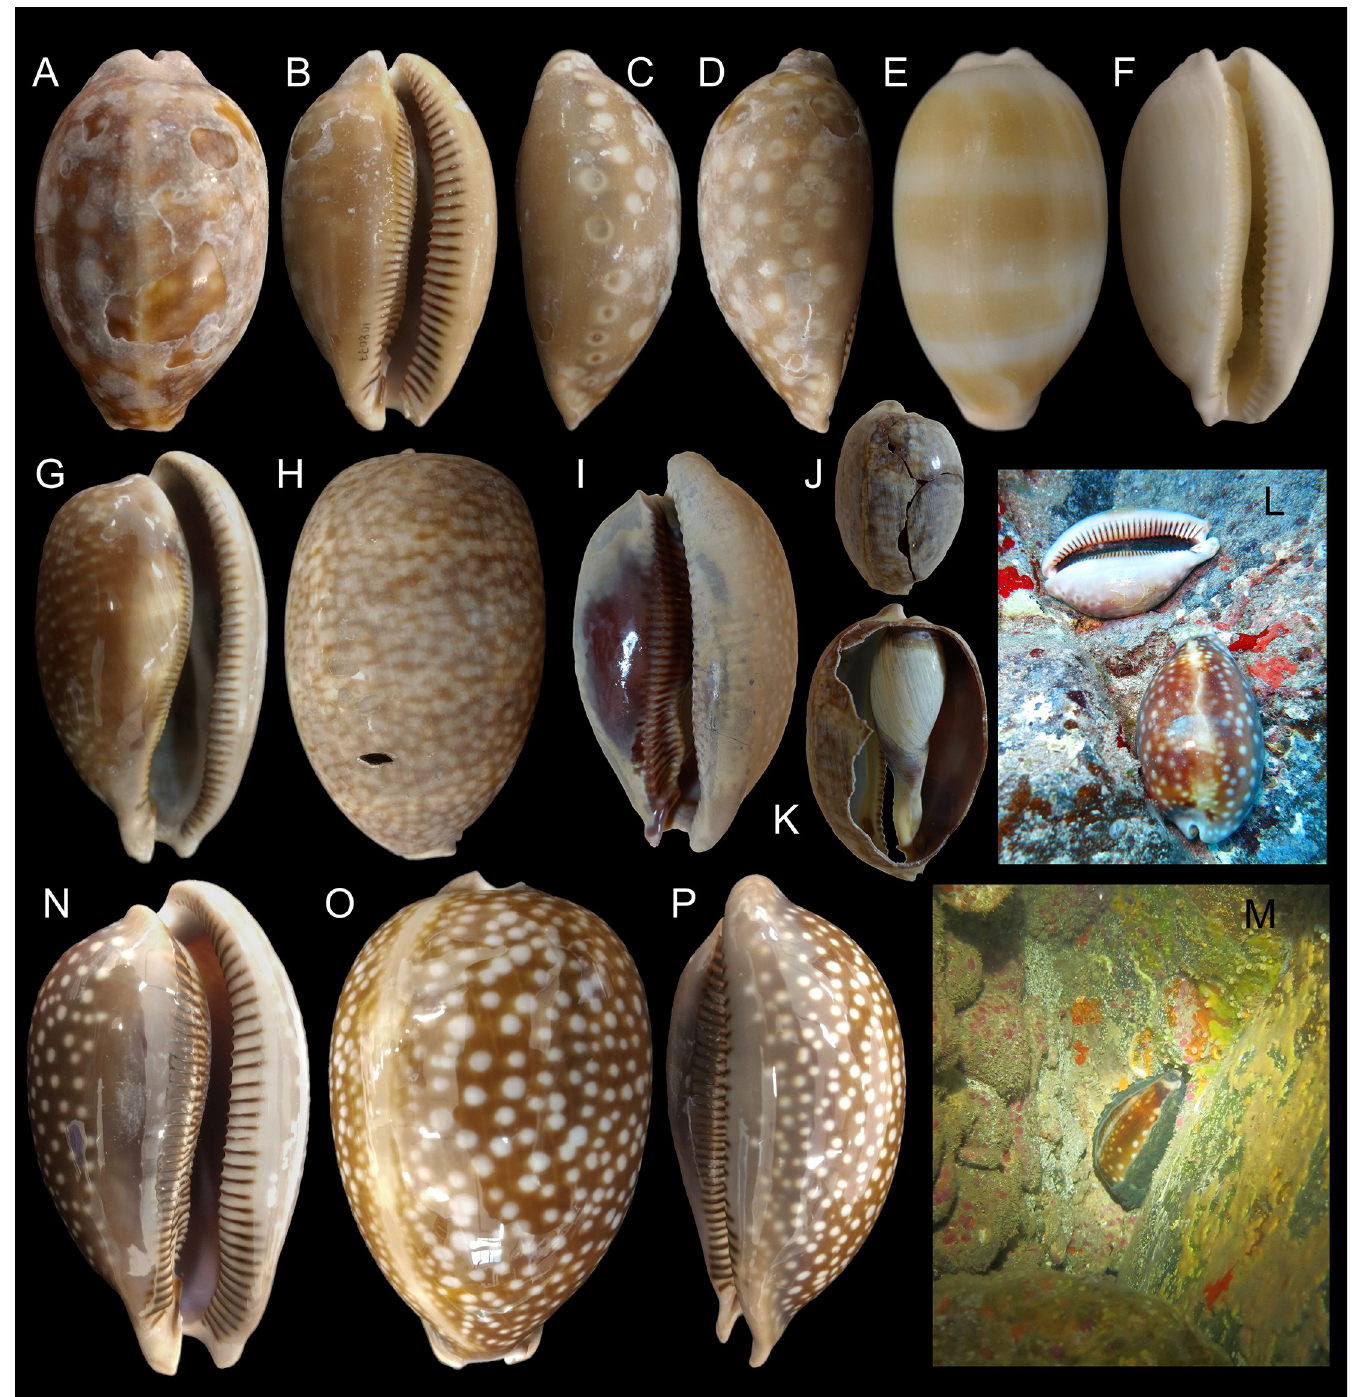
Fig 3. Macrocypraea spp shells and in situ. (A-D) M . mammoth paratype MZSP 108077 (L 95.8 mm). (A) Dorsal view. (B) Apertural view. (C) Right view. (D) Left view. E) M . mammoth MZSP 108079 subadult specimen (L 80.4 mm), dorsal view. (F) Same, apertural view. (G) M . cervus MZSP 8149, from Mexico (L 152.9 mm), Apertural view. (H) Same, dorsal view. (I-K) M . cervus ANSP 93276, from Florida (L 129.4 mm). (I) Apertural view. (J) Dorsal view (broken). (K) Same, specimen and dorsal shell wall removed. (L) Alive paratypes in situ.; (M) Alive holotype in situ. (N-P) M . cervus , MZSP 115362, from Cuba (L 98.5 mm). (N) Apertural view. (O) Dorsal view. (P) Right